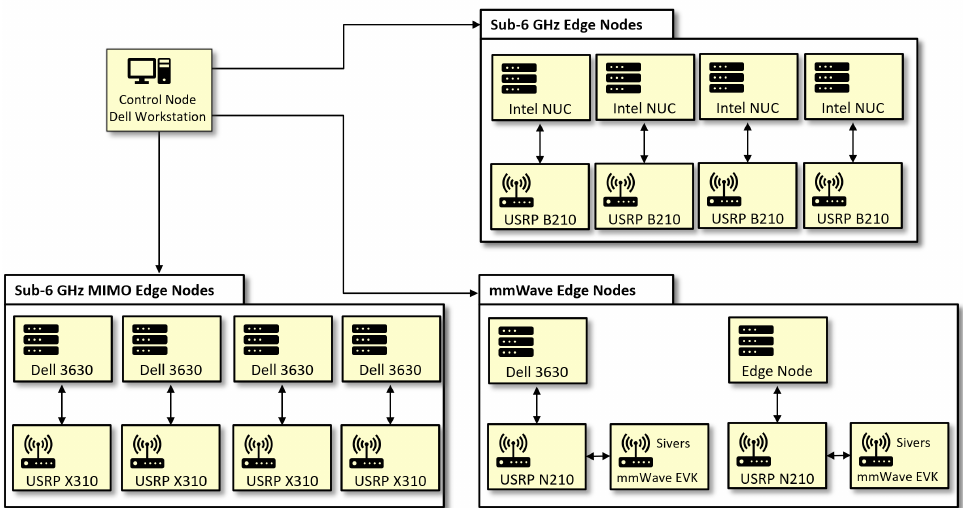
Figure 9. System architecture of the WISCANet deployment maintained in the WISCA laboratory at Arizona State